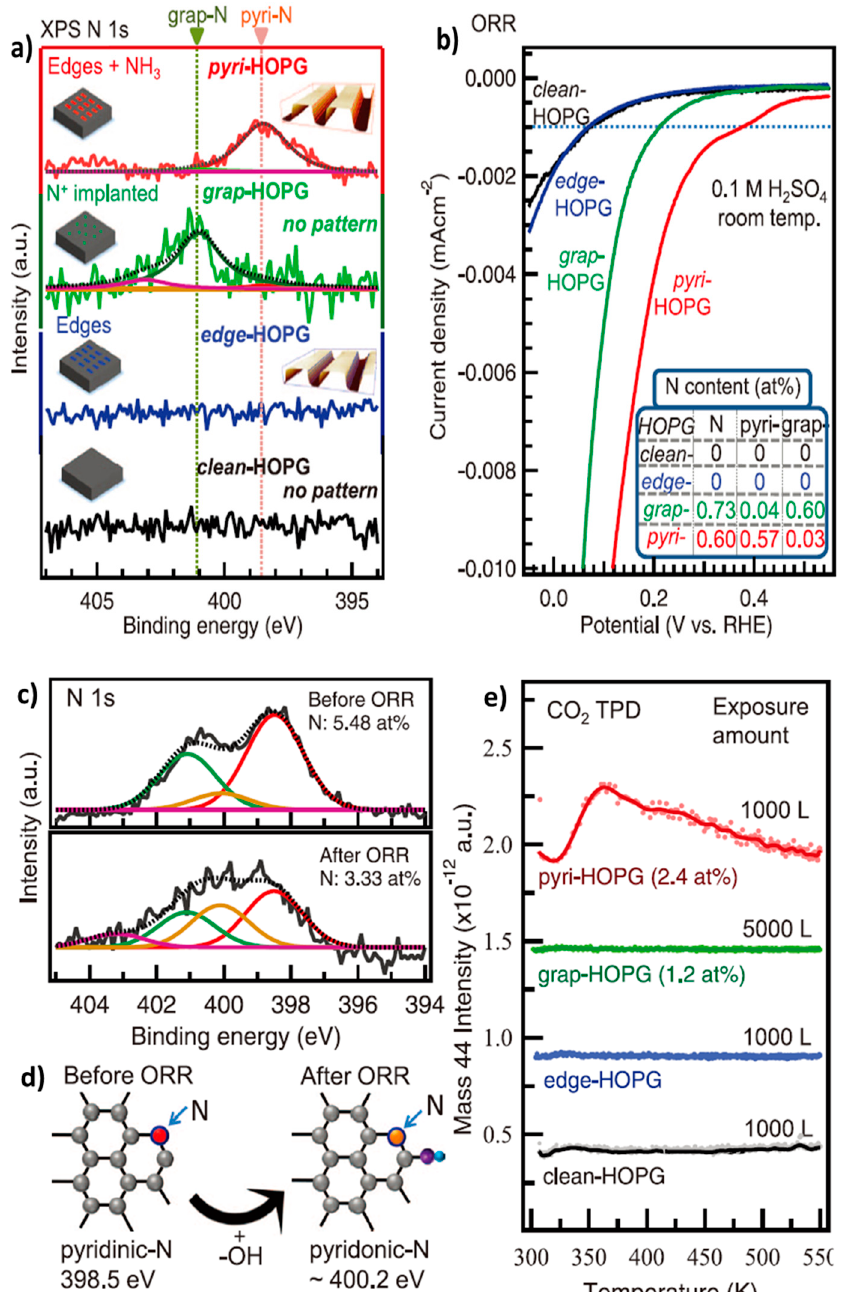
Figure 10. ( a ) The high-resolution N 1s XPS spectra determined for model catalysts. ( b ) The ORR catalytic results for model catalysts depicted in panel ( a ). Inset to the panel is nitrogen contents corresponding to the model catalysts. ( c ) N 1s XPS spectra of the N-HOPG model catalyst before and after ORR, respectively. ( d ) Schematic illustration of the formation of pyridonic N by the attachment of OH to the carbon atom adjacent to pyridinic N. ( e ) CO2-TPD results of the HOPG model catalysts. Reprinted with permission from Ref. [42], 2016, American Association for the Advancement of